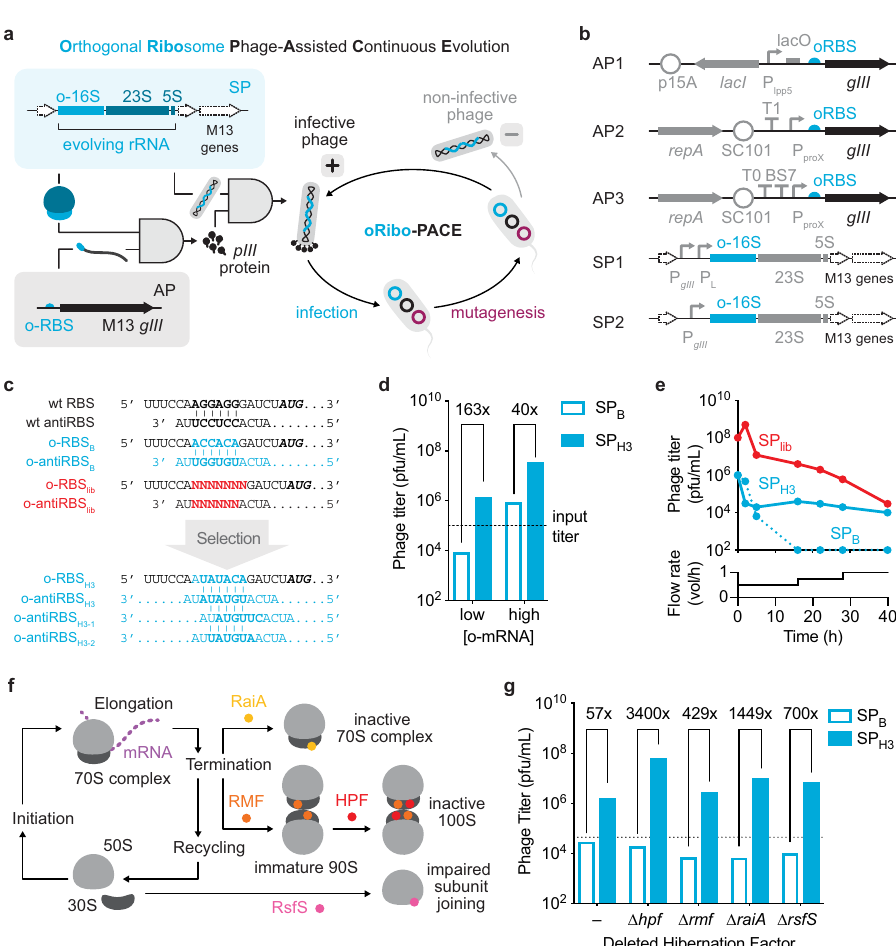
Fig. 1 Development of a PACE-compatible selection for orthogonal translation. a Schematic representation of an orthogonal rRNA-dependent PACE selection. An engineered M13 bacteriophage (selection phage; SP) encodes the o-rRNA operon in place of gIII . Upon infection, functional orthogonal ribosomes ef fi ciently translate gIII from the accessory plasmid (AP), yielding infectious phage progeny. Ef fi cient o-rRNA diversi fi cation is implemented via a mutagenesis plasmid (MP). b AP and SP designs used in directed evolution campaigns. c A comparison of native and orthogonal RBS/antiRBS pairs used in this study. d Preliminary analysis of o-rRNA-dependent phage production under low (0 mM IPTG) or high (1 mM IPTG) mRNA concentrations using AP1 H3 ( n = 2 biological replicates). e Discovery of o-antiRBS variants under continuous culturing conditions using a degenerate library in the SP-borne o-rRNA. f Schematic representation of known ribosome hibernation factors. g Comparison of phage enrichment assays using the constitutive AP2 H3 (top) in wild- type host (S2060) or host cells where ribosome hibernation factors have been deleted: hibernation promoting factor ( Δ hpf ), ribosome modulation factor ( Δ rmf ), ribosome-associated inhibitor A ( Δ raiA ), or ribosomal silencing factor S ( Δ rsfS ) ( n = 1 biological replicate). Source data are available in the